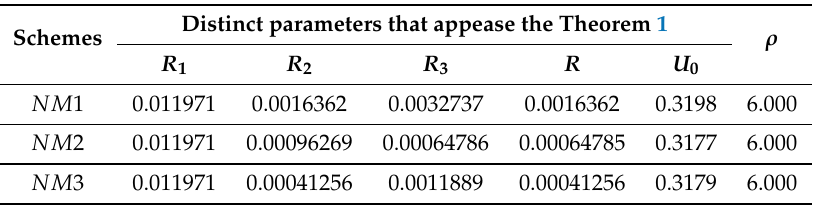
Table 8. Different radii of convergence.